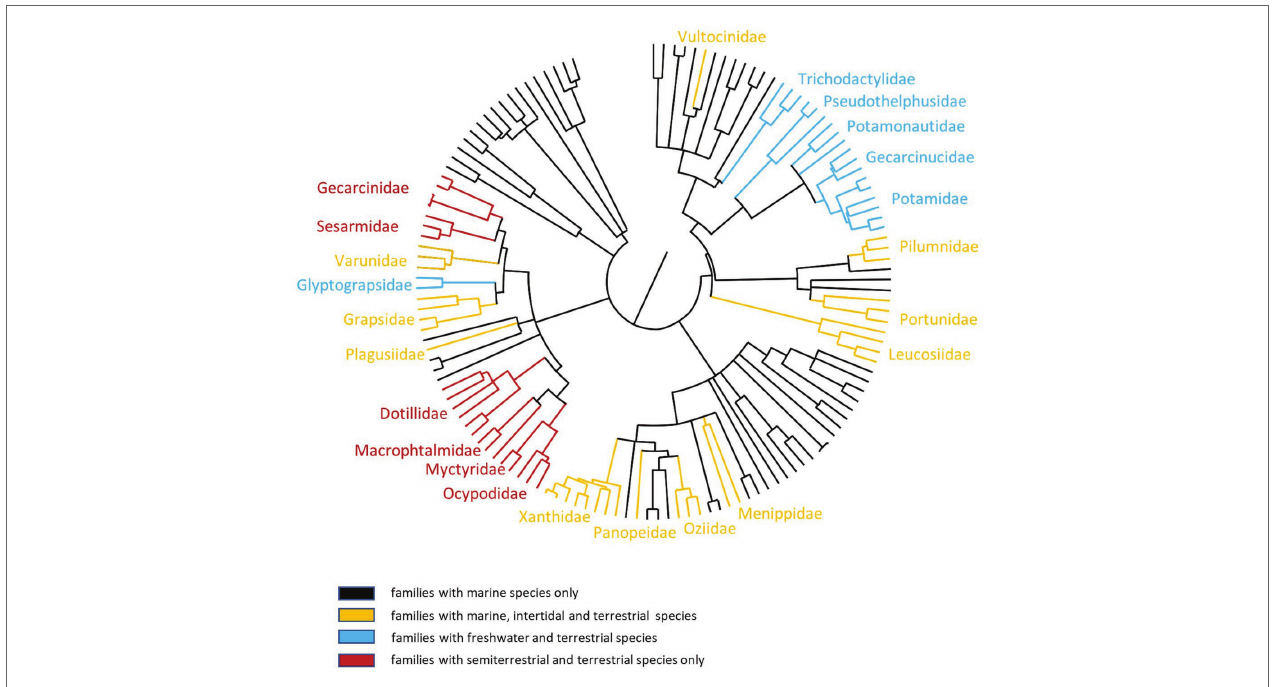
FIGURE 1 | Phylogenetic relationships among semi-terrestrial and terrestrial brachyuran crabs. Unrooted phylogenetic tree of 134 true crab species representative of 57 out of 98 Brachyuran families (see Ng et al., 2008). The order of tree branches is derived from the TimeTree database (http://timetree.org/; Kumar et al., 2017) on the basis of data of Tsang et al. (2014). The color code of the different brachyuran families represents the different habitat they colonized (black lines = families including only marine species; orange lines = families including marine, intertidal and terrestrial species; turquoise lines = families including freshwater and terrestrial species; red lines = families including exclusively semiterrestrial and terrestrial species). Only the taxonomic names of families with terrestrial species are shown on the